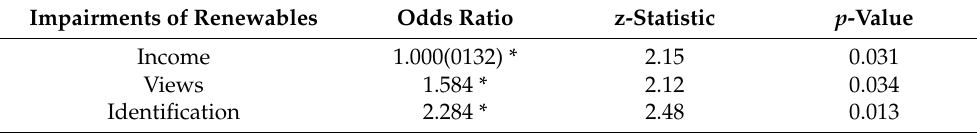
Table 2. Logistic regression: people believe one must live with impairments of renewables. Impairments of Renewables Odds Ratio z-Statistic p -Value Income 1.000(0132) * Views